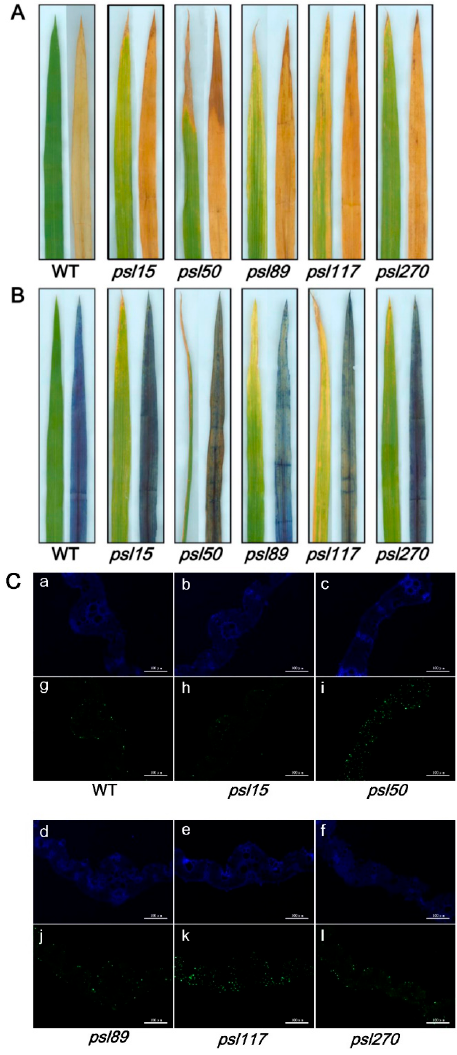
Figure 5. Histochemical analysis and terminal deoxyribonucleotidyl transferase-mediated dUTP nick-end labeling (TUNEL) assays in WT and the mutants. ( A ) 3,3-diaminobenzidine (DAB) assay at the tillering stage; ( B ) Trypan Blue staining at the tillering stage; ( C ) TUNEL assay at the tillering stage. Blue signal represents 4 ′ ,6-diamino-phenylindole (DAPI) staining; green color represents positive result. a–f are negative controls for g–l, respectively. The scale bars indicate 100 μ M.